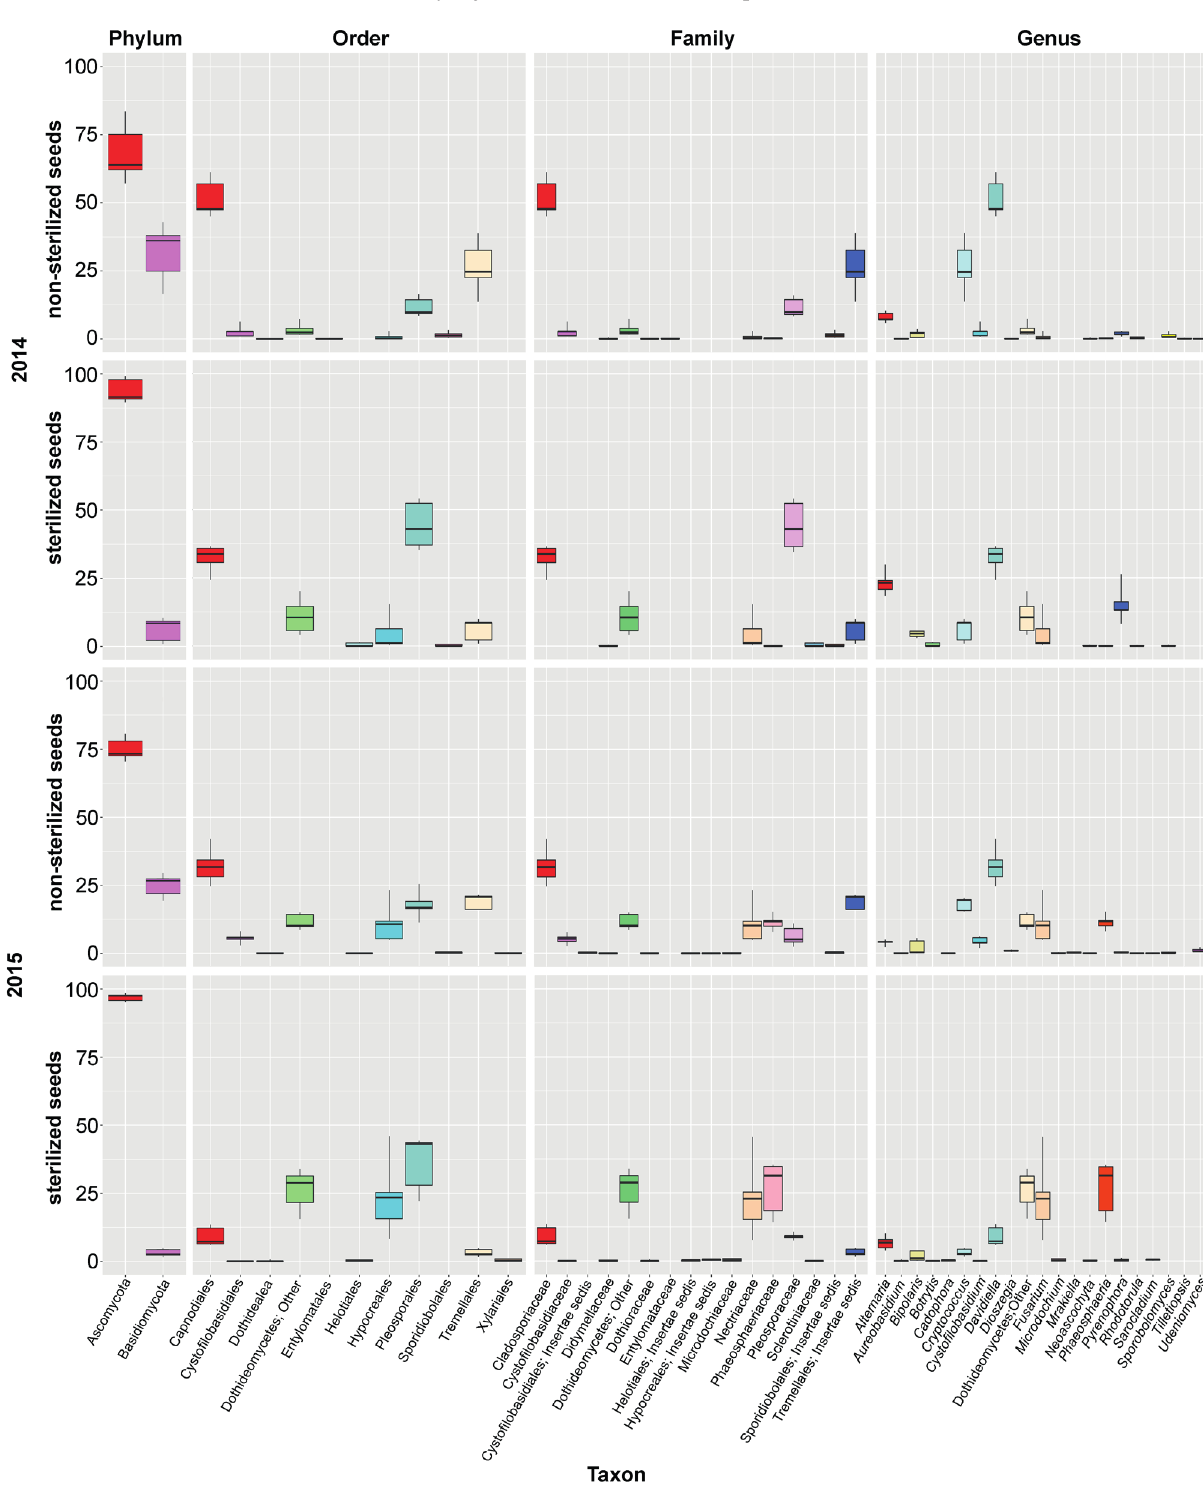
Figure 2 Boxplots depicting relative abundance (%) of the taxonomic ranks in sterilized and non-sterilized grain samples harvested in 2014 and 2015. All taxonomical ranks are marked by different colors. The boxplots consist of square boundaries indicating the 25th and 75th percentiles. Whiskers indicate the 10th and 90th percentiles, and the line inside the box represents the median. Outliers are not